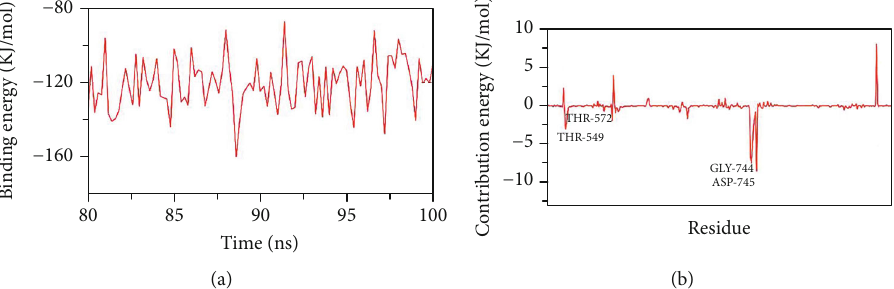
Figure 20: (a) Total binding energy plot of quinovic acid bound with 7T9K at 100-ns time frame. (b) Contribution energy plot with interacting amino acids. Table 3: Ligands with Azithromycin and their molecular properties.